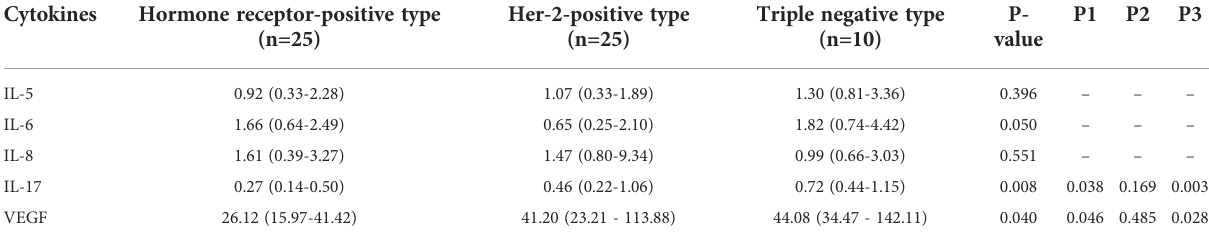
TABLE 7 Cytokines associated with molecular typing.